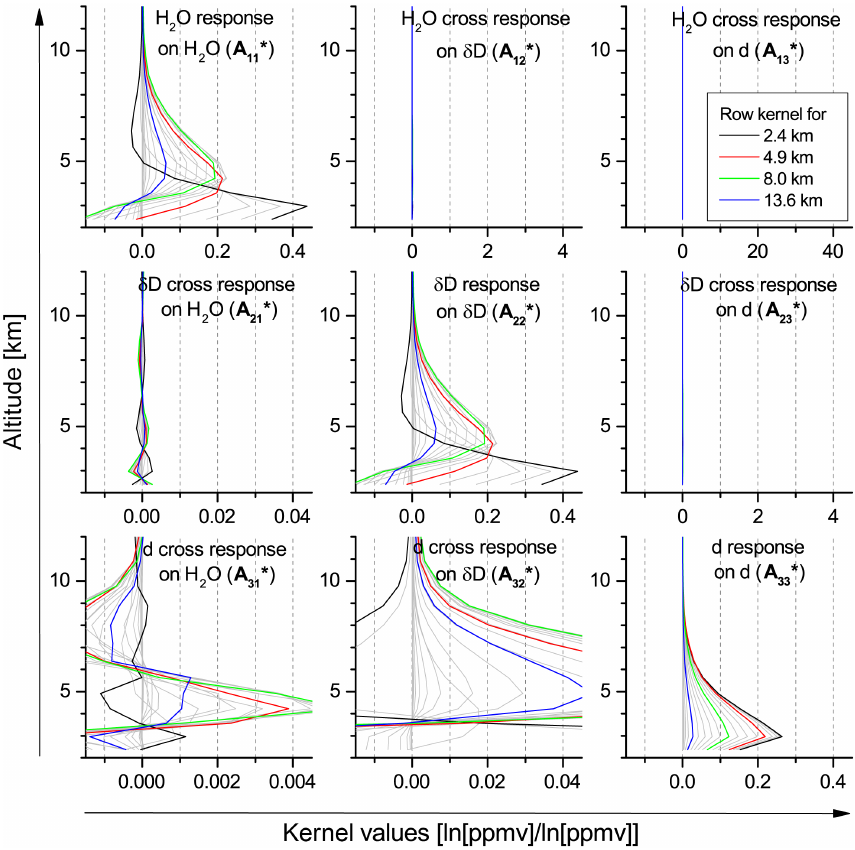
Figure 1. Row entries of the nine blocks of the NDACC/FTIR full averaging kernel matrix in the {H 2 O, δ D,d} proxy basis system and after a posteriori correction ( A ∗ as given in Eq. 3). The kernel is for the retrieval of a ground-based FTIR spectrum measured on 09:41UT on 24 Jul 2013 (the retrieval result of this measurement is one of the data points shown in Fig.